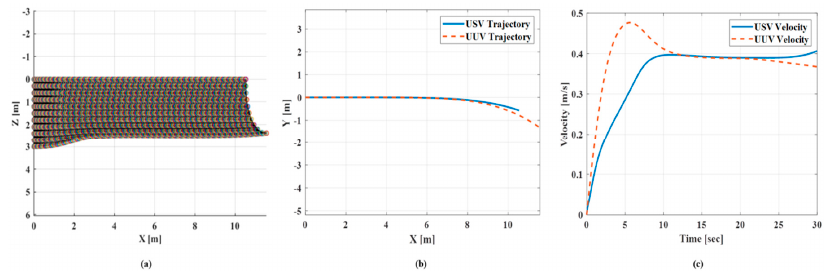
Figure 22. Simulation results of dynamic behavior of unmanned ocean platform when the USV and UUV velocities are different: ( a ) X - Z plane trajectory; ( b ) X - Y plane trajectory of the USV and UUV; ( c ) Velocity of the USV and UUV.